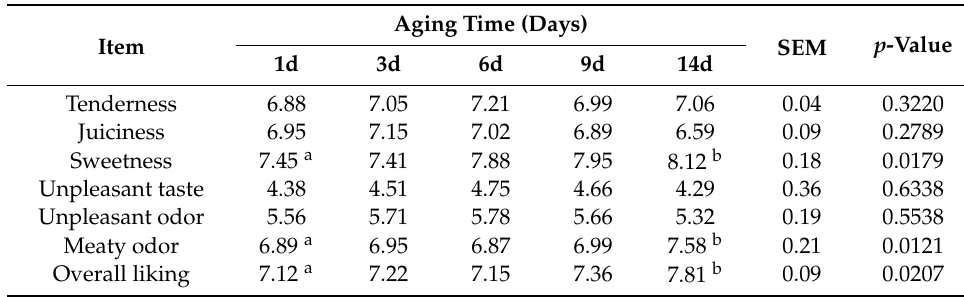
Table 6. E ff ect of aging time on sensory panel evaluation foal meat steaks aged for 14 days under vacuum conditions ( n = 20 samples for each aging